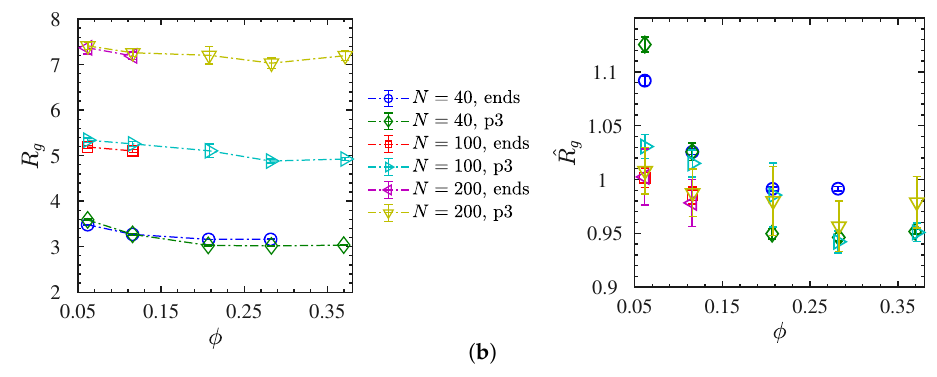
Figure 5. ( a ) Radii of gyration R g for dispersed systems, ( b ) their normalized values ˆ R g = R g / R neutral g , both versus NP volume fraction. Dash-dotted lines are guides to the eye.